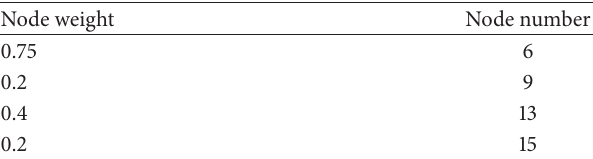
Table 1: The domain set for Figure